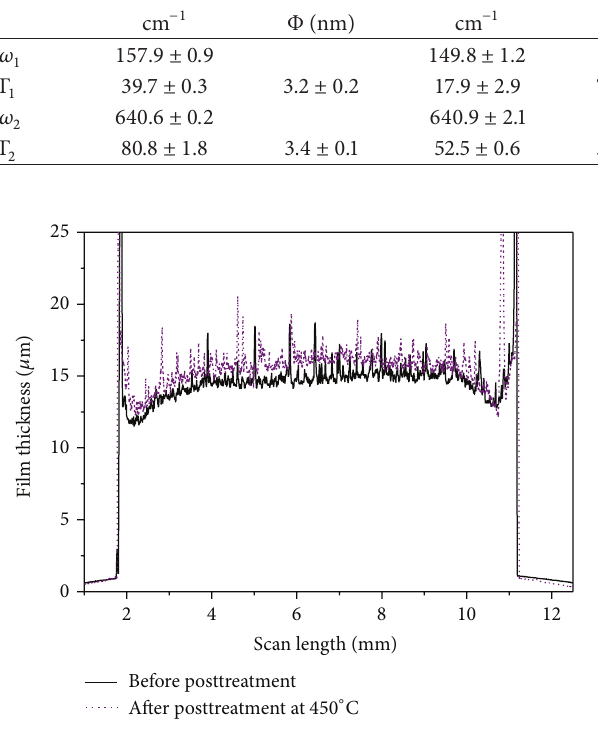
Figure 1: Surface profile of the TiO 2 film before (black solid line) and after (purple dotted line) the colloidal posttreatment sintered at 450 ∘ C.